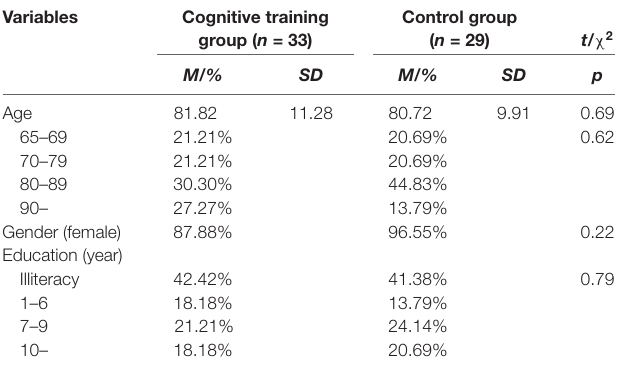
TABLE 1 | Demographic information of cognitive training group and control group. Variables